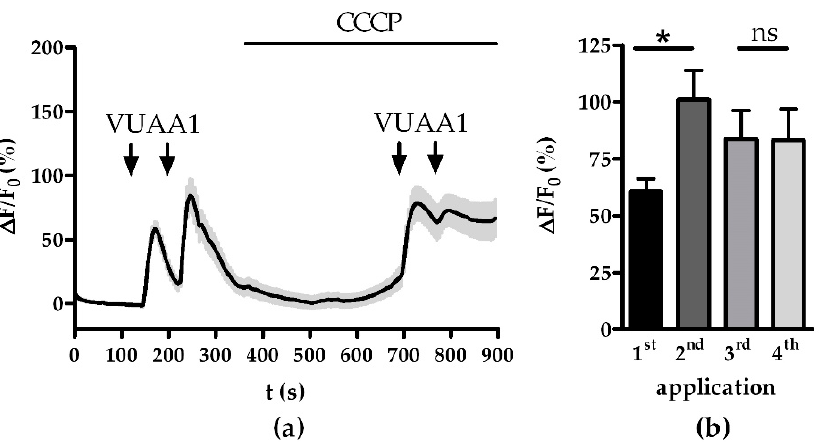
Figure 2. Sensitization of Orco channels is abolished by the disturbance of Ca 2+ homeostasis by CCCP: ( a ) averaged time course of Ca 2+ fluorescence responses to two sets of stimulations with 30 µM VUAA1 (arrows); ( b ) maximum Ca 2+ responses for VUAA1 stimulations from ( a ). Data represent mean ± SEM ( n = 28), Student’s paired t -test, ns, not significant, * p < 0.05.